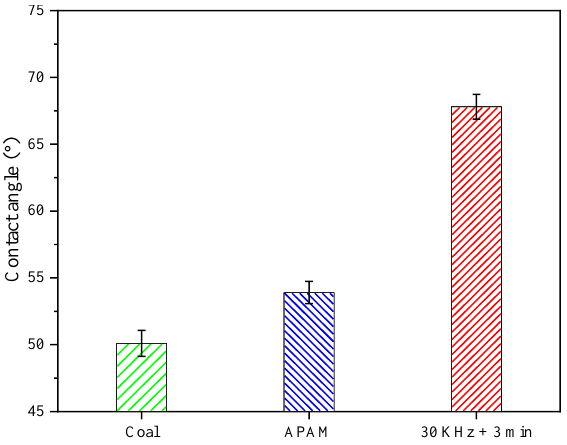
Figure 9. Slurry contact angle under different